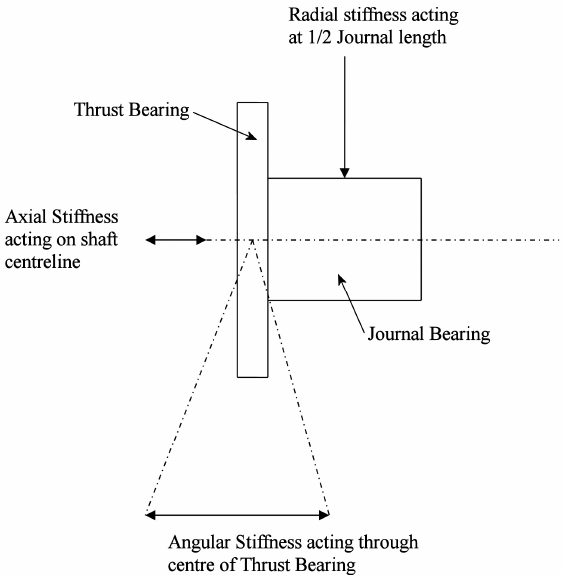
Figure 2. A schematic view of the rotary section (the only moving part) of an air-bearing and the planes of action of stiffness. This section is contained within the casing of the air-bearing assembly and floats on a film of high-pressure air. The journal bearing is composed of a cylinder that bears the radial weight of the load. The thrust bearing is in the form of a disc and it is attached to the journal bearing to prevent a displacement along the axis of rotation (the shaft centerline). For the ϕ -axis, the thrust bearing has a particularly important role as the load is subject to variations during a rotation of the ω -axis.